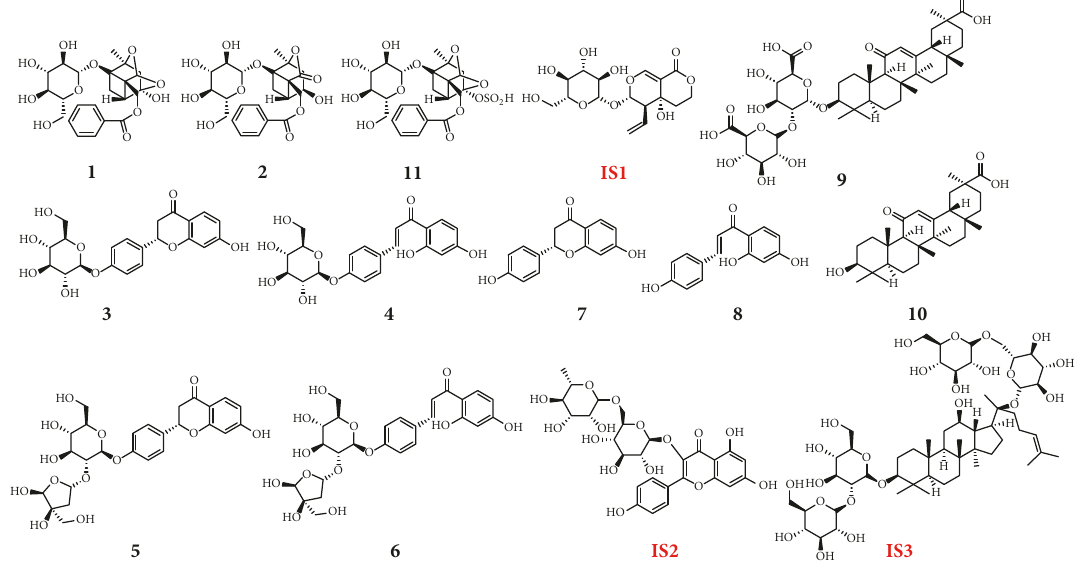
Figure 1: Chemical structures of the eleven standard reference compounds and ISs. 1: paeoniflorin; 2: albiflorin; 3: liquiritin; 4: isoliquiritin; 5: liquiritin apioside; 6: isoliquiritin apioside; 8: liquiritigenin; 9: isoliquiritigenin; 10: glycyrrhizic acid; 11: glycyrrhetinic acid; 12: paeoniflorin sulfonate; IS1: ginsenoside Rb1; IS2: swertiamarin; IS3: